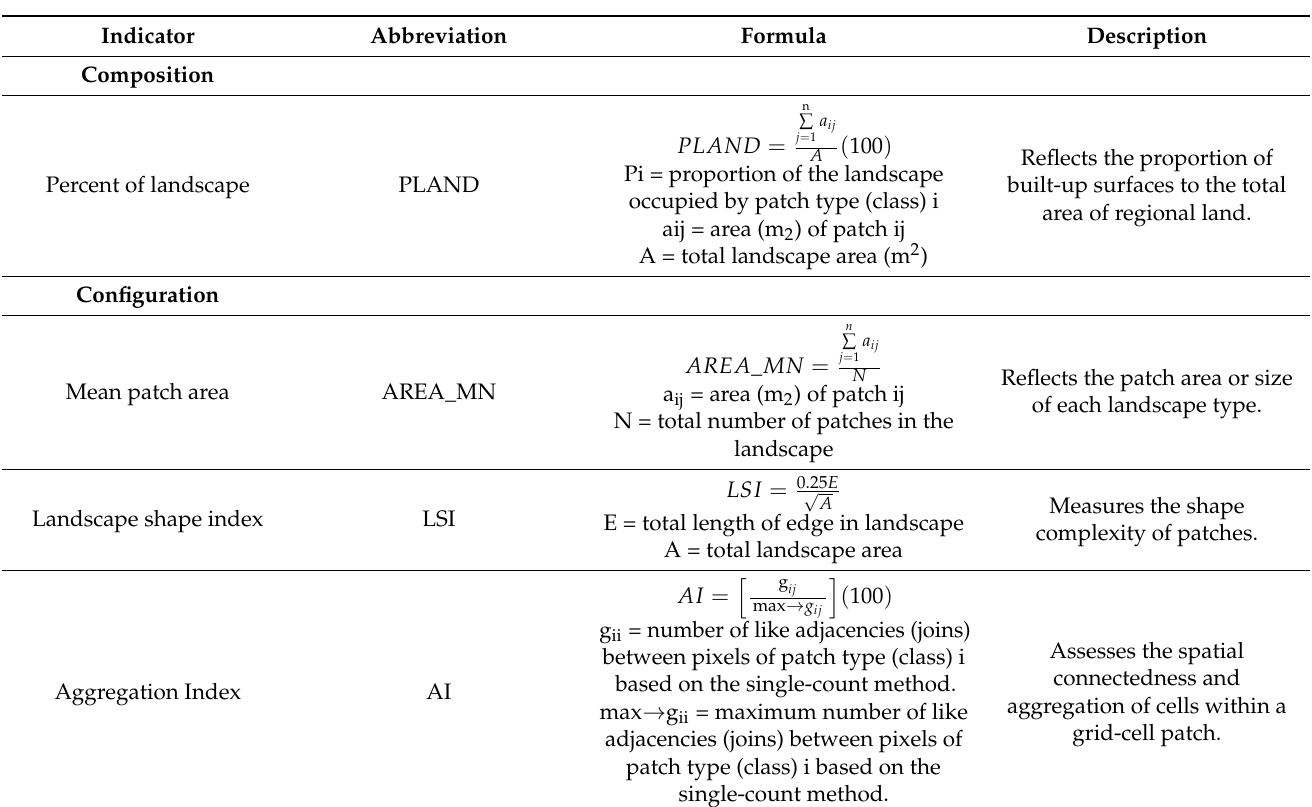
Table 3. Detailed description of the metrics included in the